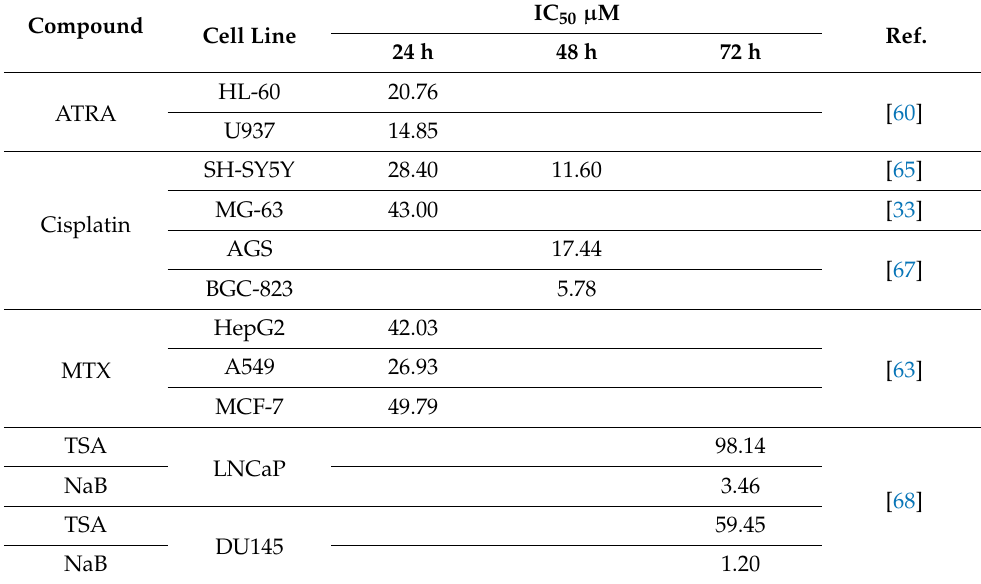
Table 3. IC 50 ( µ M) of the different antitumor drugs in the respective cell